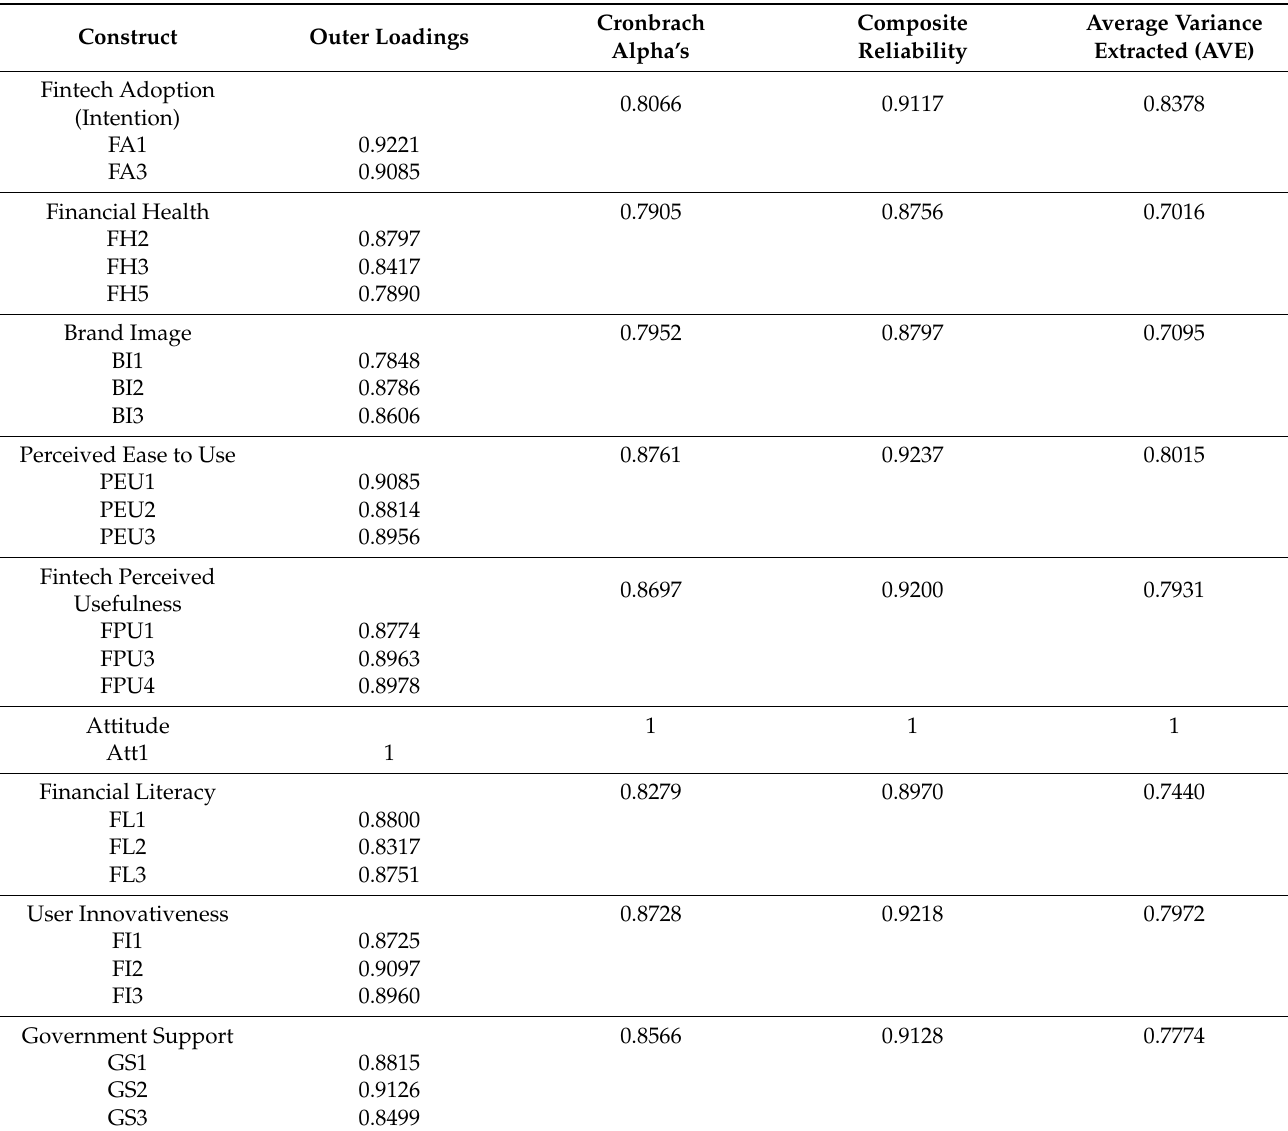
Table 4. Results of the measurement model